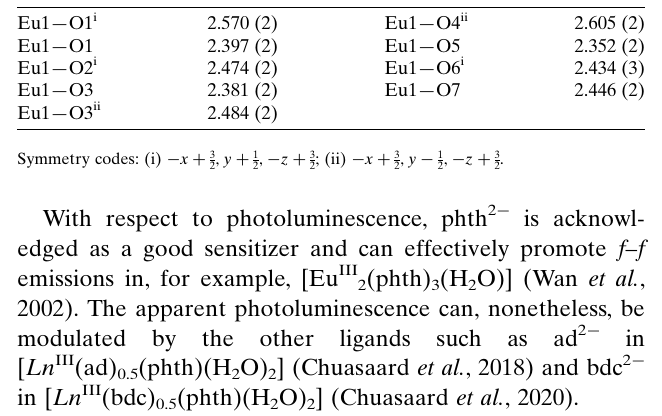
Figure 1 Coordination modes of phth 2 (cid:2) and Hphth (cid:2) found in lanthanide coordination compounds deposited to the CSD (Groom et al. , 2016) with frequency of appearance in